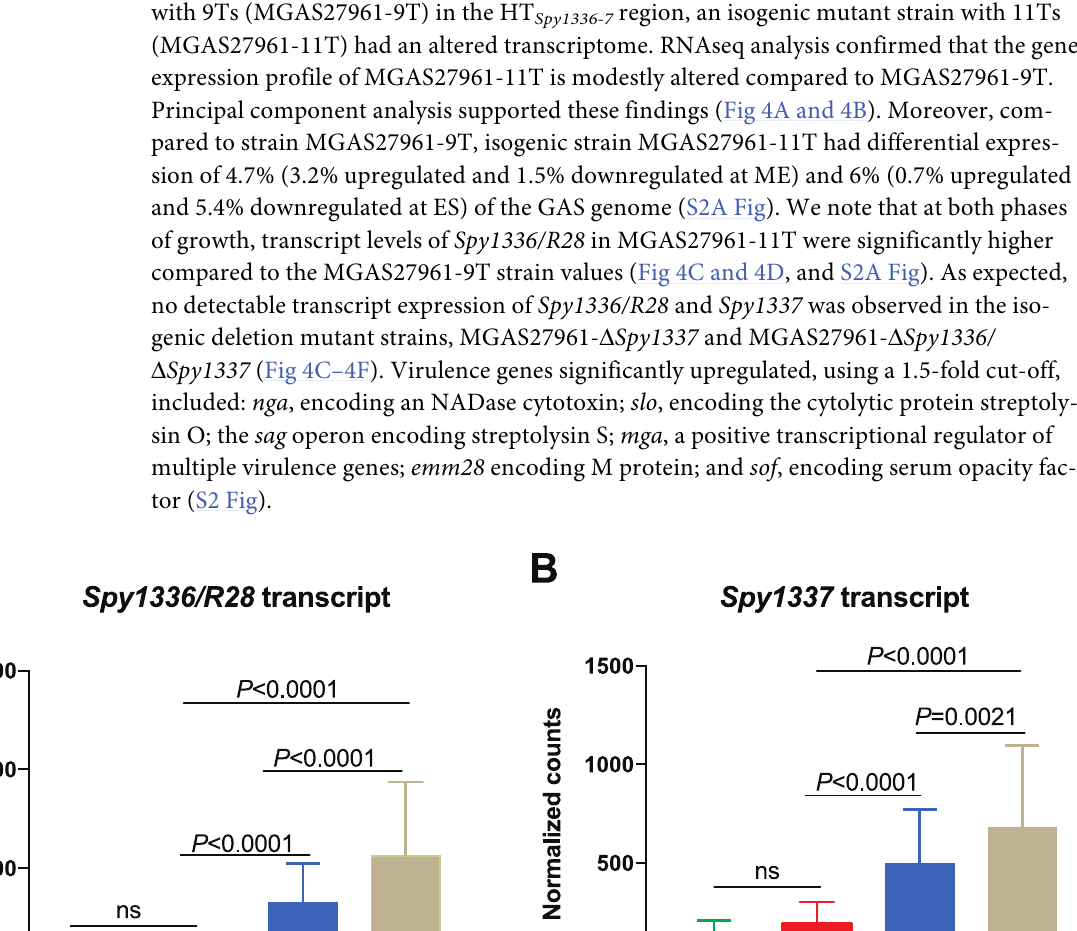
PLOS ONE | https://doi.org/10.1371/journal.pone.0229064 March 26,